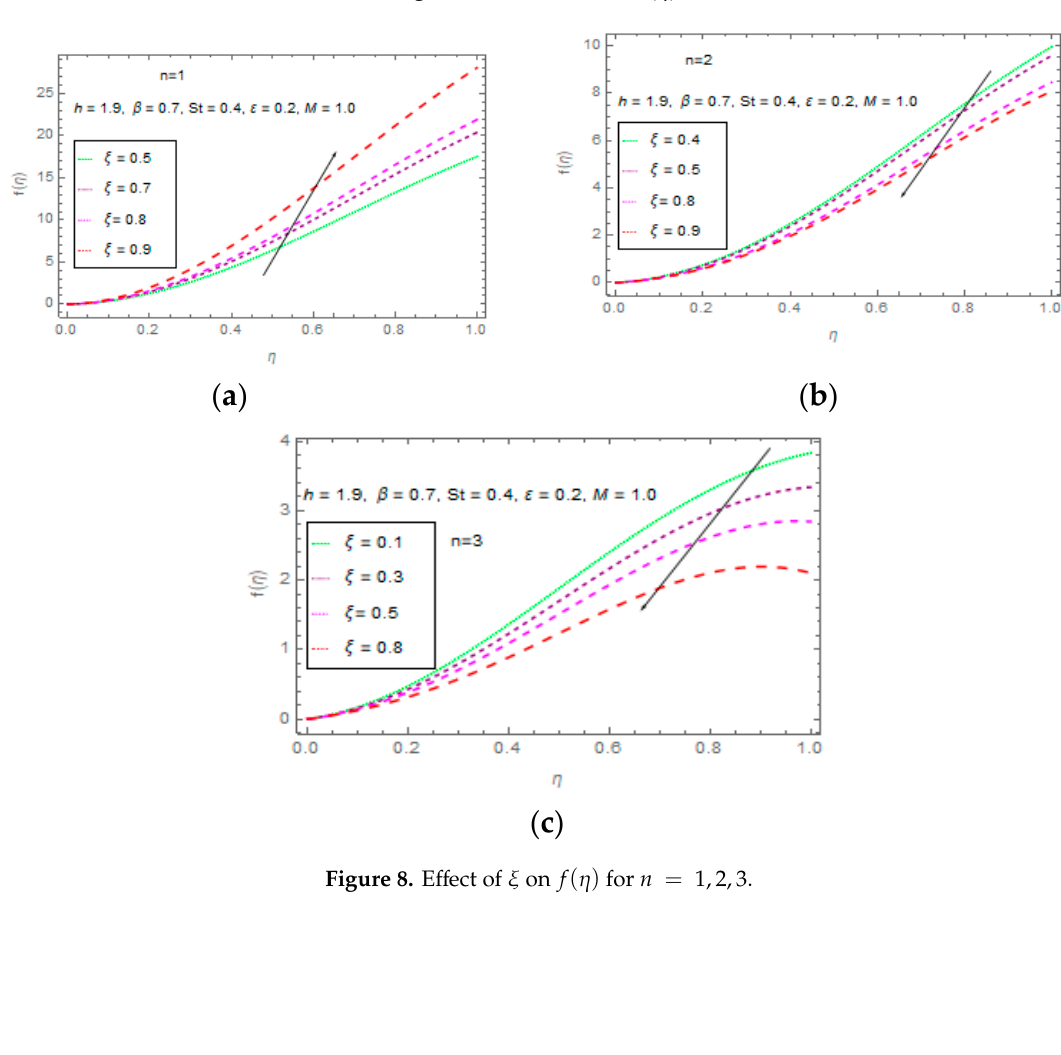
Figure 7. Effect of 𝑀 on 𝜃(𝜂) . Figure 7. E ff ect of M on θ ( η ) .